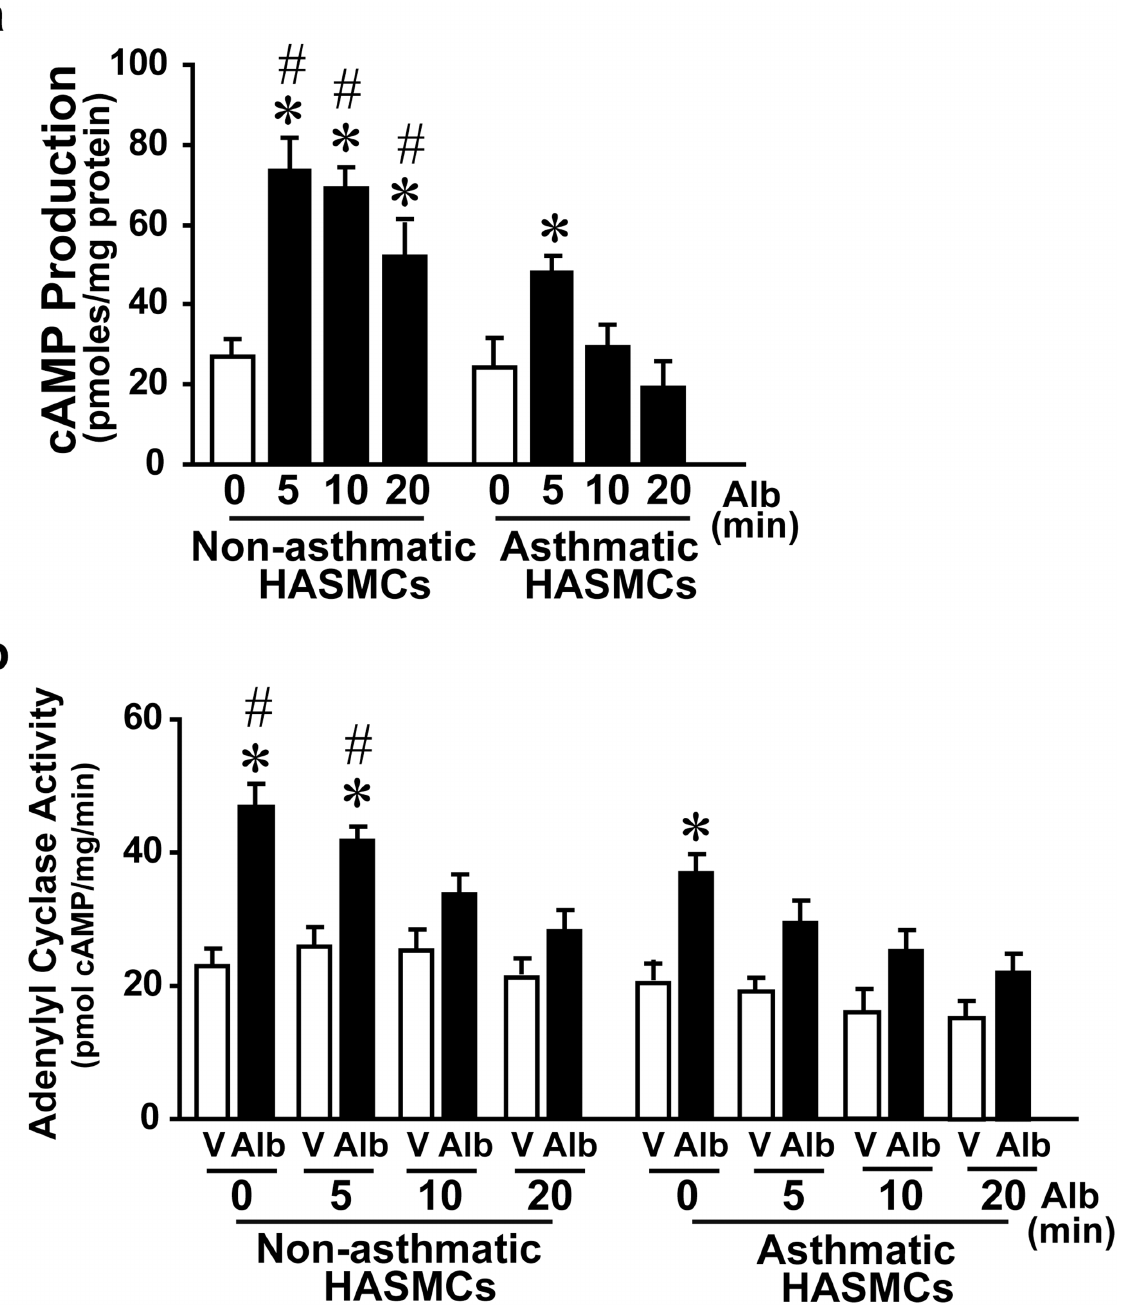
Fig 1. β AR function in primary human airway smooth muscle cells (HASMCs) from lungs of non-asthma (Non- asthmatic ASM) and asthma (Asthmatic ASM) patients. a , Non- asthmatic ASM and asthmatic ASM cells were stimulated with β -agonist albuterol (0, 5, 10 & 20 minutes (min)). The cell were lysed and assessed for the ability to generate cAMP. * p < 0.005 vs. non-asthmatic ASM or asthmatic ASM 0 min (untreated), #p < 0.05 vs. asthmatic ASM 5, 10, 20 min, (n = 6 per group, 6 non-asthmatic ASM and 6 asthmatic ASM). b , Plasma membranes were isolated from non-asthmatic ASM and asthmatic ASM cells following pre-treatment of cells with albuterol for 0, 5, 10, and 20 min. The cell-free membranes were stimulated with albuterol to measure adenylyl cyclase activity by providing radioactive 32[P] γ -ATP and measuring cAMP generation. * p < 0.01 vs. respective in vitro vehicle stimulation, #p < 0.05 vs. ASM in vitro albuterol stimulated 0 and 5 min, (n = 6/group). V, Vehicle; Alb, Albuterol ( β -agonist).